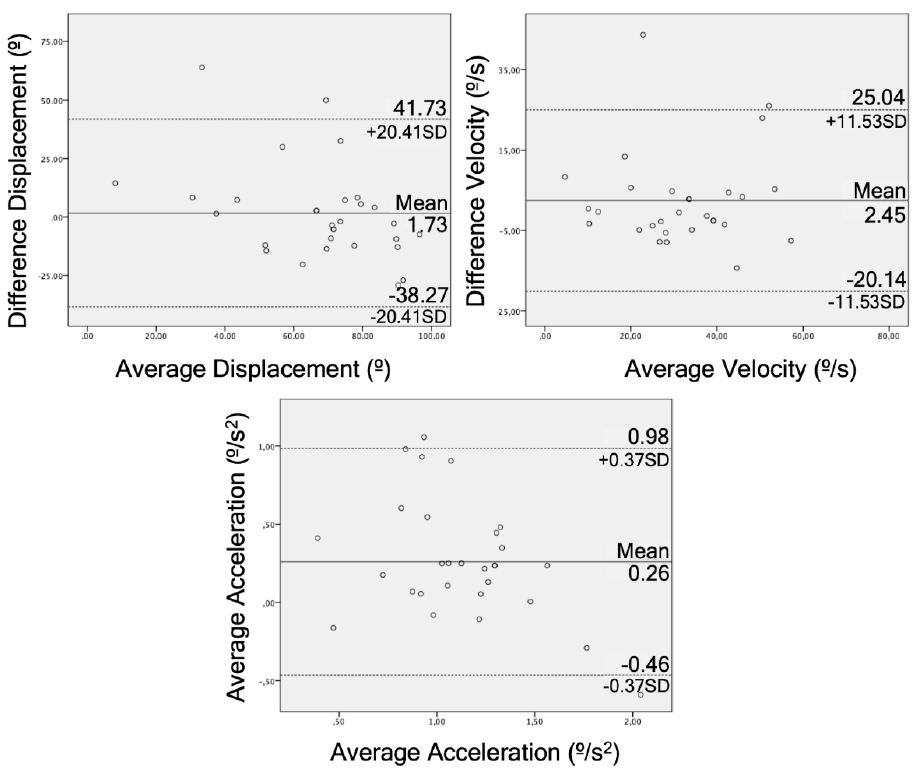
Figure 4. Bland–Altman plots for displacement, velocity, and acceleration in the bending test comparing the RGB-D camera and IMU. The lines represent the mean of the differences and limits of agreement.